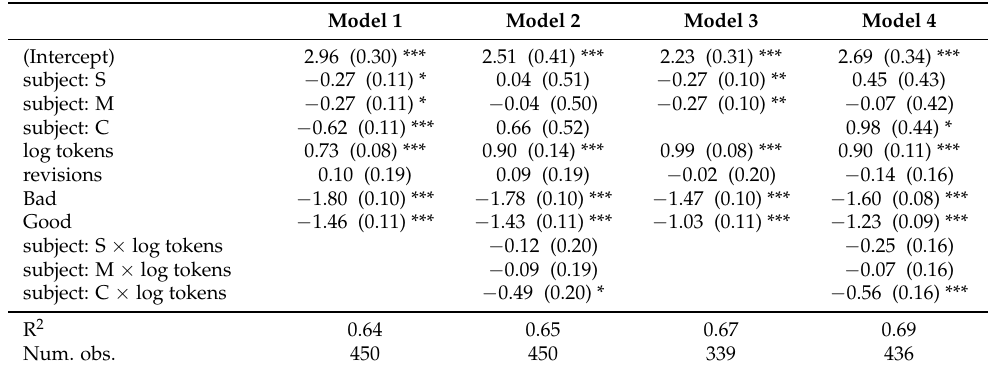
Table 8. Models for from scratch translation keystroke count. Model 3 is fitted leaving out Subject D. Model 4 removes cases where no keystrokes were